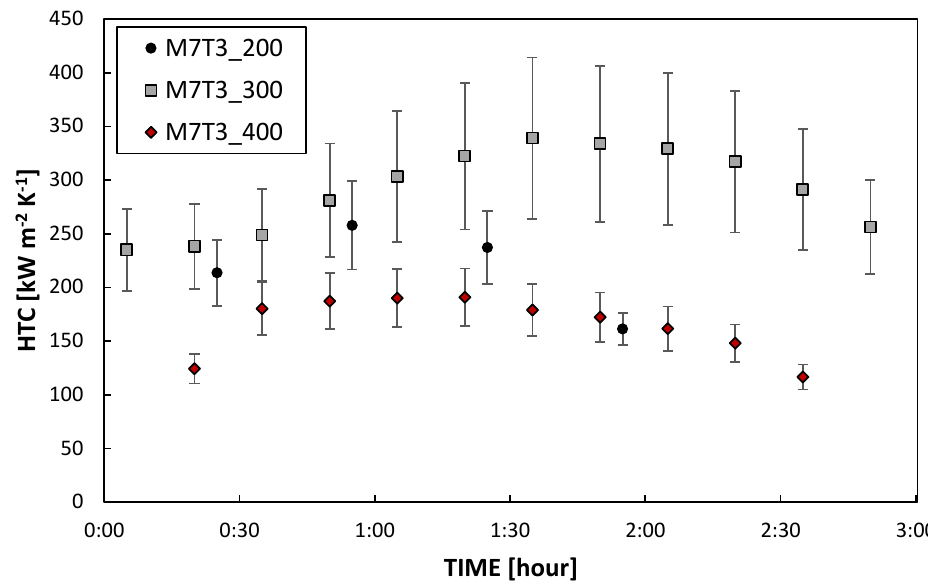
Figure 6. HTC of M7T3_200, M7T3_300 and M7T3_400 coatings. All data were recorded at constant saturation temperature (105 °C), constant vapor velocity (2.6 m s −1 ) and constant heat flux (400 kW m −2 ).